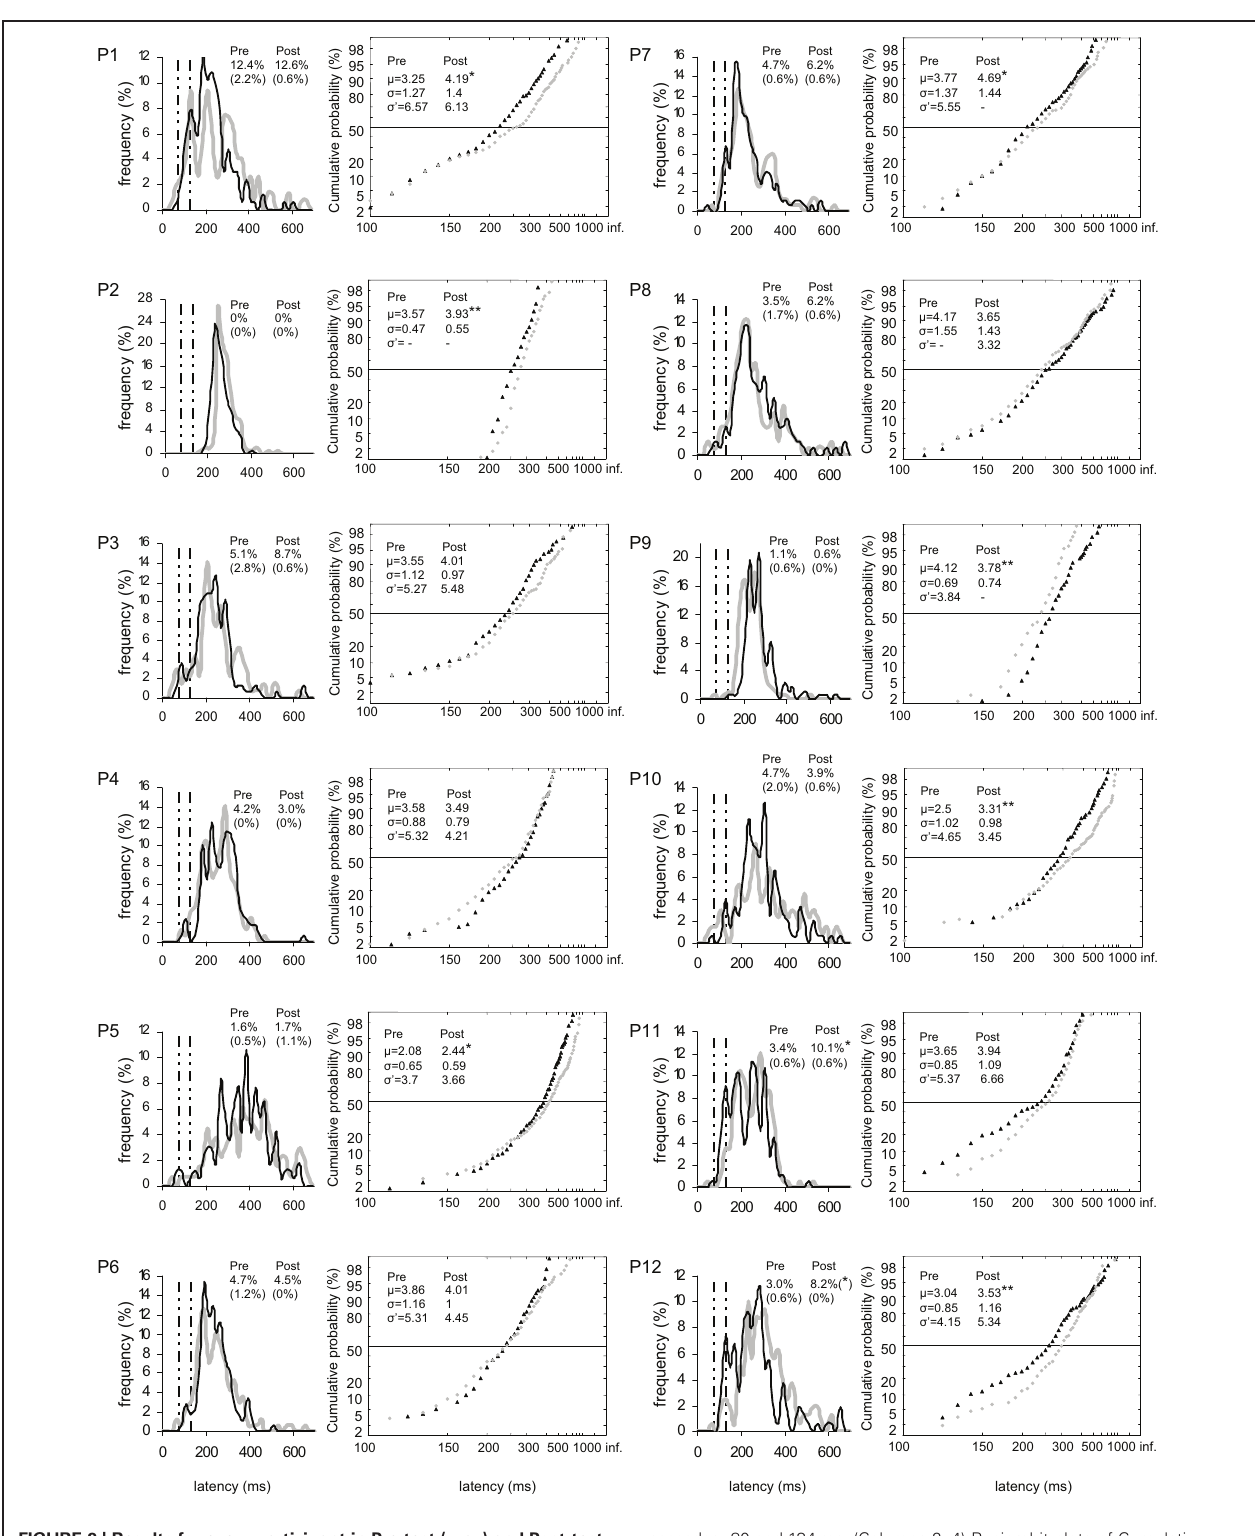
saccades: 80 and 134ms. (Columns 2, 4) Reciprobit plots of Cumulative probability (in %) as a function of Latency (in ms) for saccades between 80 and 999ms in valid direction, and μ , σ , and σ (cid:4) values. Asterisks indicate statistical significant differences ( ∗∗ P < 0 . 01, ∗ P < 0 . 05, ( ∗ ).05 < P < 0 . 10). N = 133–185 in frequency histograms; N = 130–185 in reciprobit